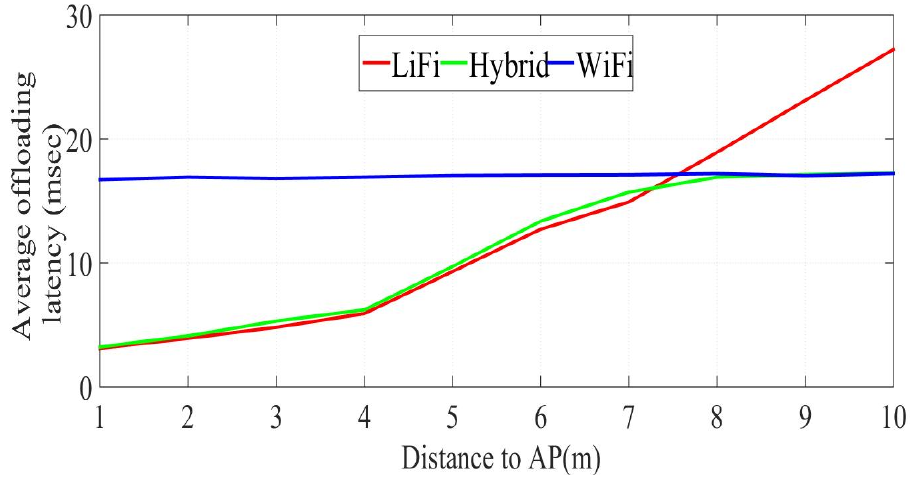
Figure 5. Average offloading latency of the three systems with the distance from the access point (AP).